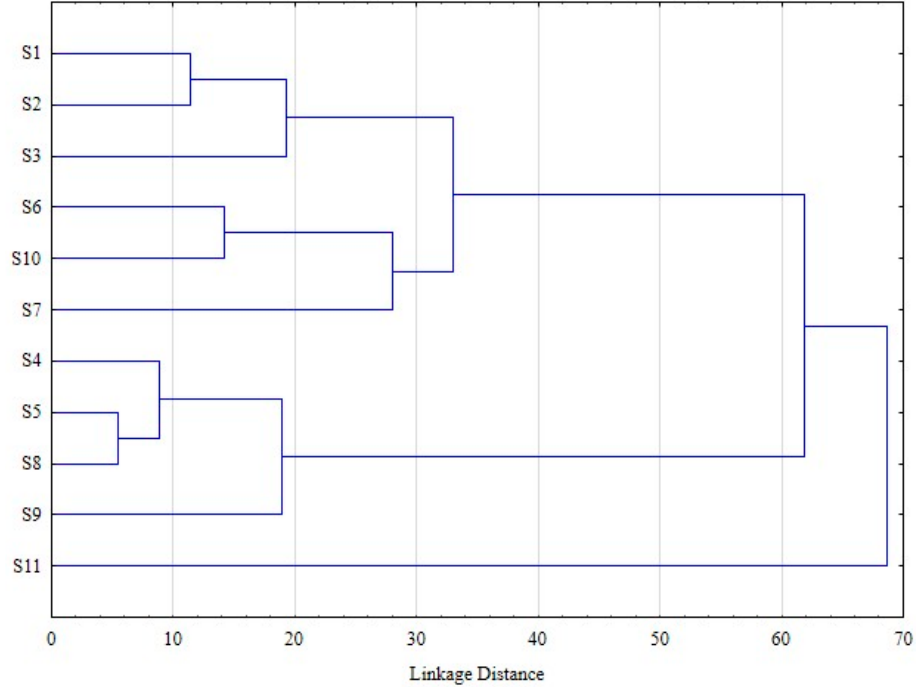
Figure 3. Cluster analysis based on percentages of excreted PVL and PVA metabolites in the 11 subjects (complete linkage, Euclidean distance).